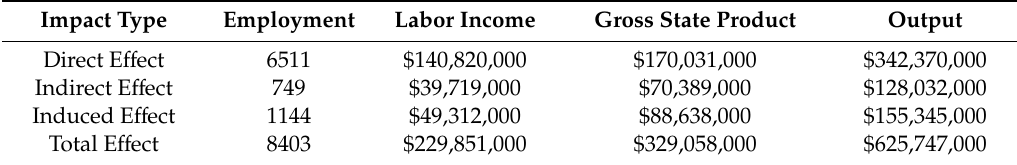
Table 5. Economic contribution of on-premise consumption sales and associated wholesale activities.